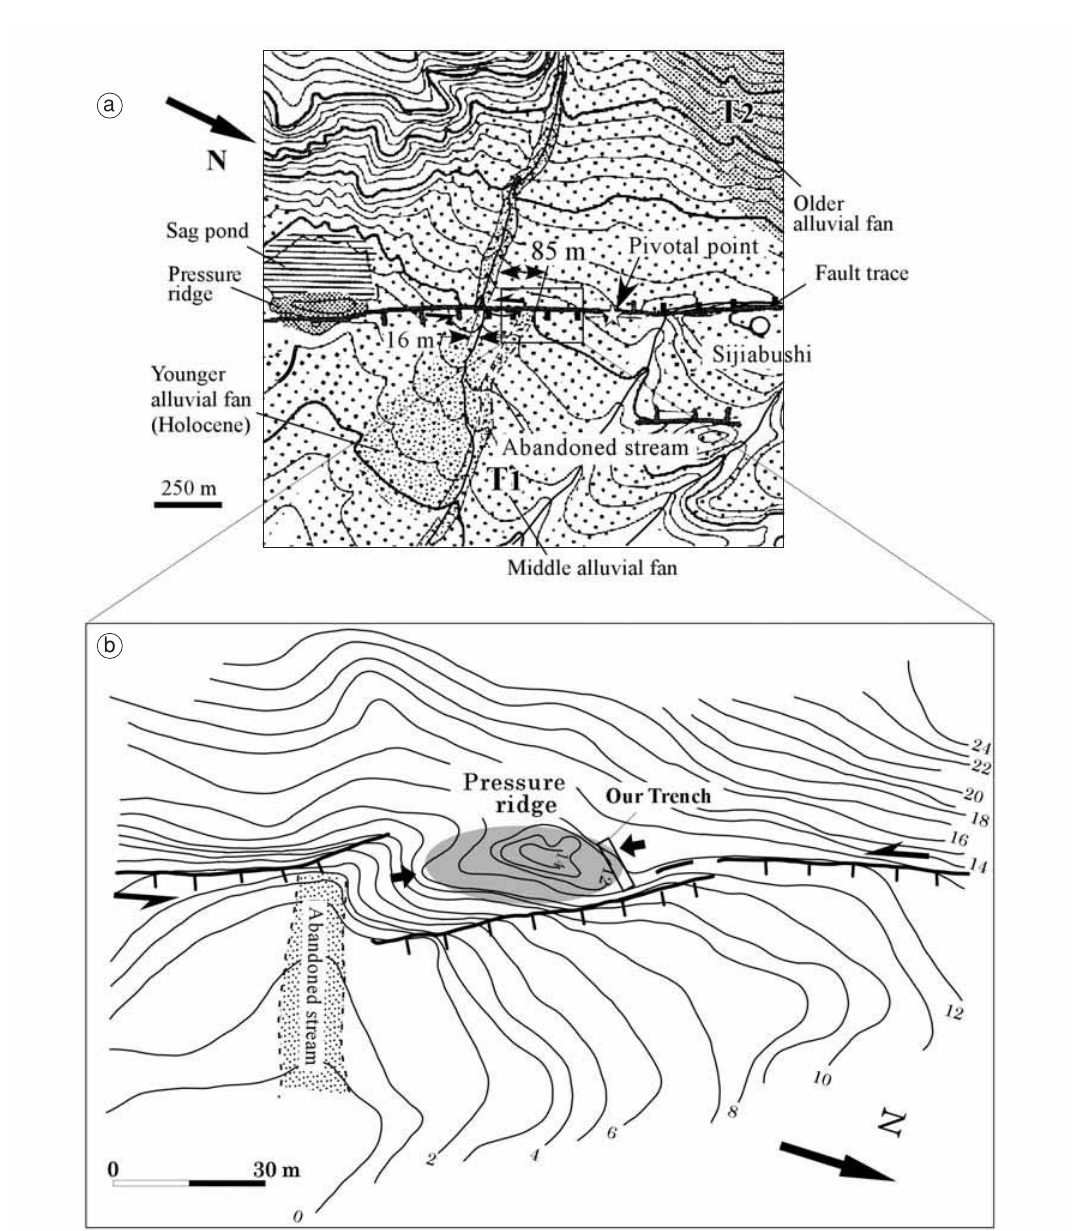
Fig. 7a,b. a) Geomorphologic map of Zemuhe Fault (location shown in fig. 2). Fault scarp is marked by the thick line; ticks are on the downthrown side of the fault. Eighty-five-meter lateral displacement of abandoned stream is shown. Contour data (10 m intervals) are from 1:50000 topographic maps. b) Detailed map of part of fault. Topographic contours of 1 m were constructed from surveying and the thick lines with teeth show fault scarplet and the rupture of the A.D. 1850